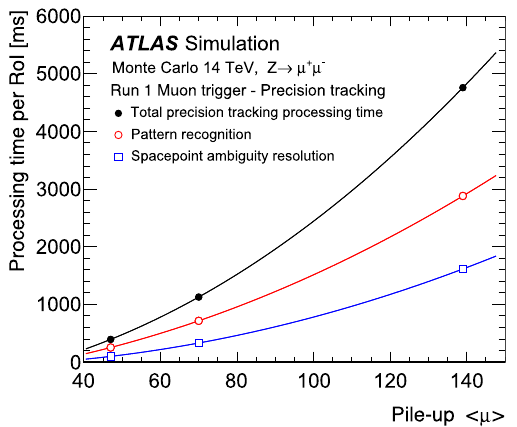
Fig. 2 The total processing time for the Run 1 precision tracking tim- ing as a function of pile-up interaction multiplicity